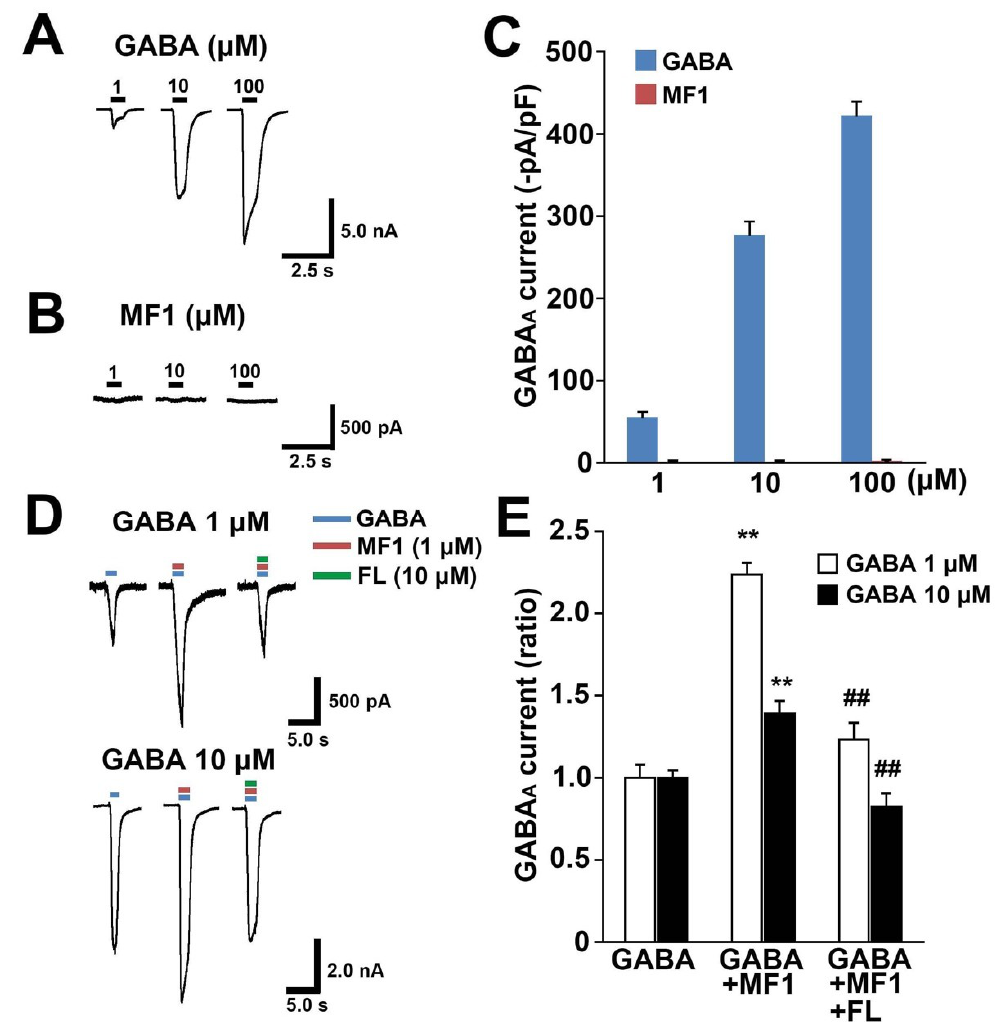
Figure 1. Effects of MF1 on GABA currents in GABA A receptor-expressing cell. ( A ), ( B ) Representative traces treated with ( A ) GABA (1 – 100 μm) and ( B ) MF1 (1–100 μm). ( C ) Peak current observed by treatment with GABA (1 – 100 μm) and MF1 (1–100 μm) was normalized to membrane capacitance (GABA: n = 10 per group; MF1: n = 8 per group). Error bars represent SEM. ( D ) Representative traces from cells treated with GABA (1 and 10 μm) in combination with MF1 (1 μm) and/or flumazenil (10 μm). ( E ) MF1 (1 μm) enhanced GABA (1 and 10 μm) currents, which were blocked by flumazenil (10 μm) ( n = 7 per group). Error bars represent SEM. ** p < 0.01 vs. each GABA alone treatment. ## p < 0.01